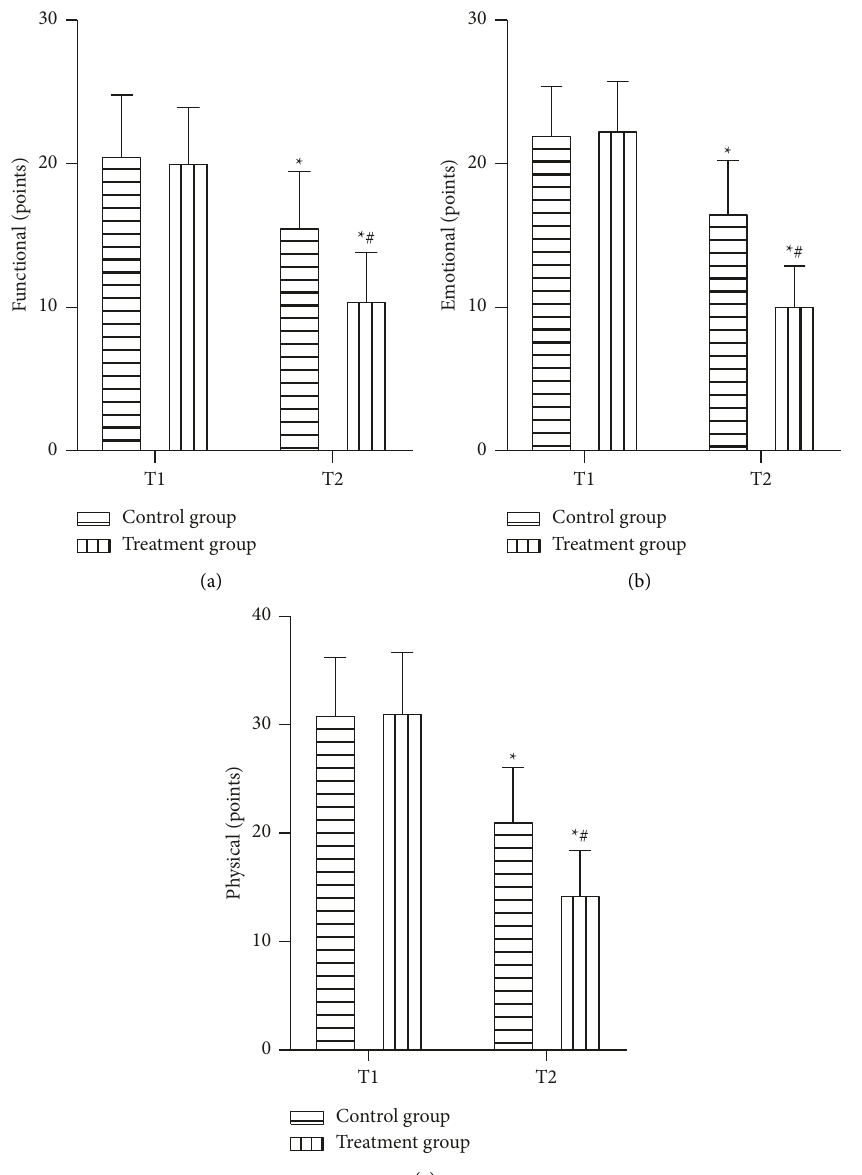
Figure 3: (a) functional scores, (b) affective scores, and (c) physical scores. ∗ indicates a significant difference ( P < 0 . 05) between each group compared with the same group at T1. # indicates significant difference ( P < 0 . 05) between the 2 groups at